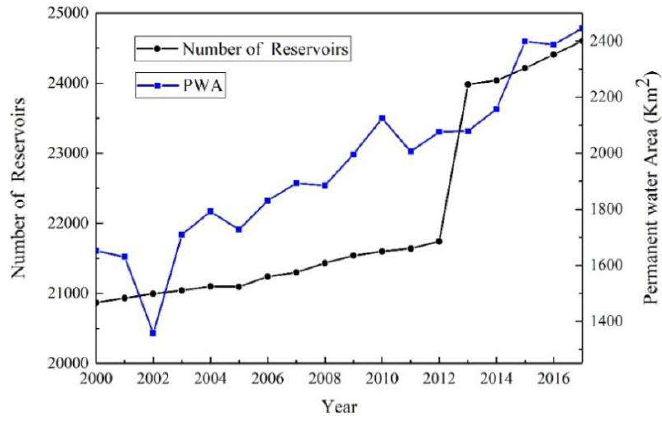
Figure 9. Variations of reservoirs count in SWC.